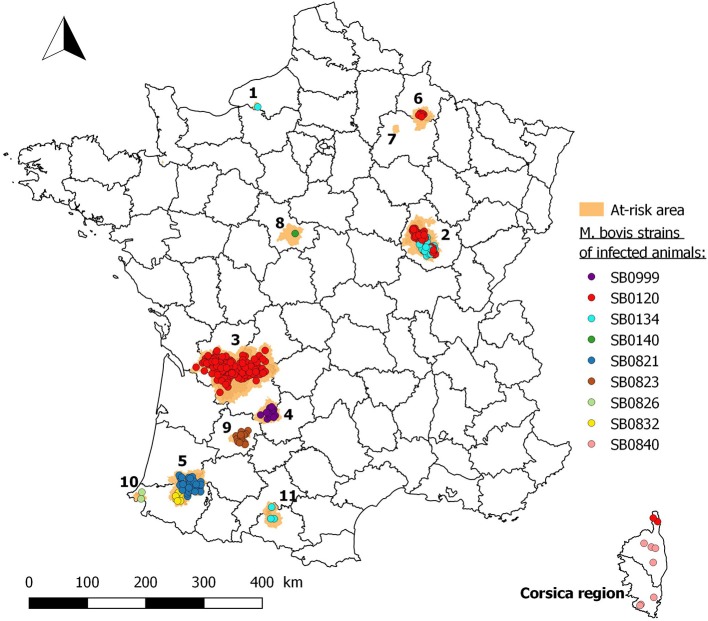
Location of M. bovis strains in wildlife in France (1: Brotonne-Mauny forest; 2: Côte-d'Or; 3: Dordogne/Charente/Charente-Maritime/Haute-Vienne/Corrèze/Gironde; 4: Dordogne/Lot; 5: Béarn; 6: Ardennes/Marne; 7: Marne (Reims Mountain); 8: Loir-et-Cher (Sologne); 9: Lot-et-Garonne; 10: Pays Basque; 11: Ariège/Haute-Garonne).